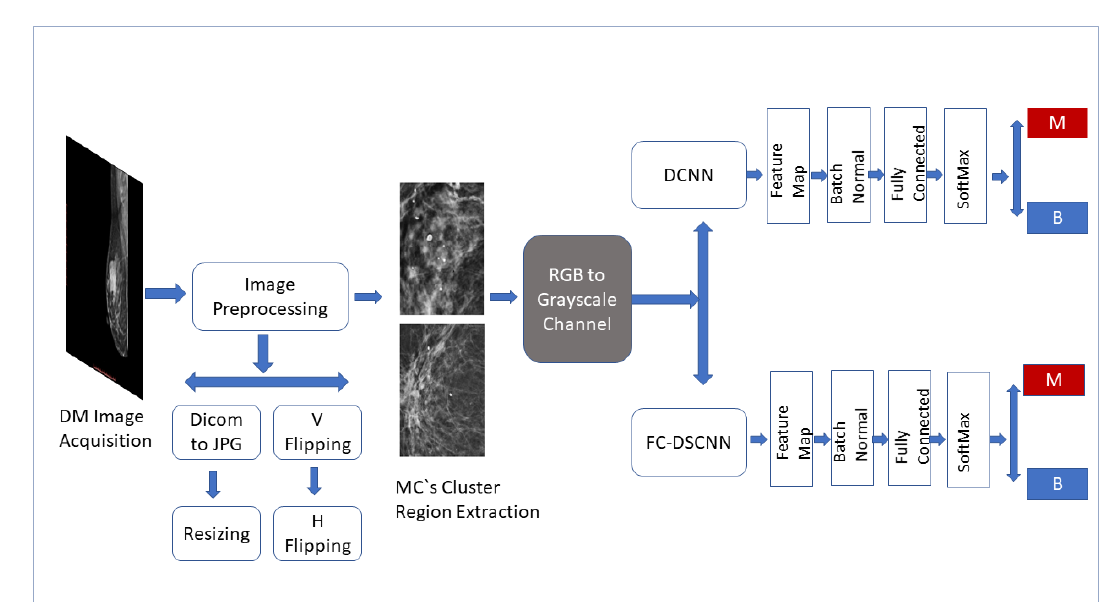
Figure 1. Framework of the proposed CAD system. The breast cancer classification framework has four steps: image preprocessing and augmentation, microcalcification ROI segmentation, RGB to grayscale channel conversion, and microcal- cification cluster classification to predict malignant and benign